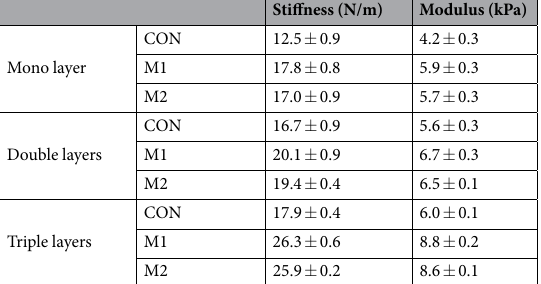
Table 1. Stiffness and modulus of layered cell sheets prepared with CON, M1 and